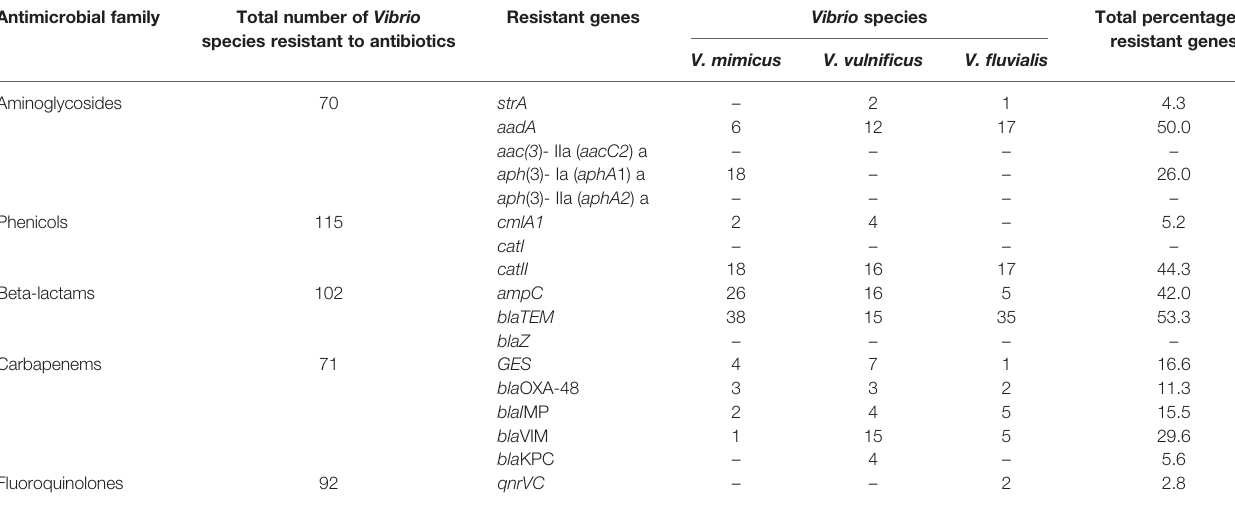
TABLE 5 | Distribution of antimicrobial resistant genes among Vibrio resistant species. Antimicrobial family Total number of Vibrio species resistant to